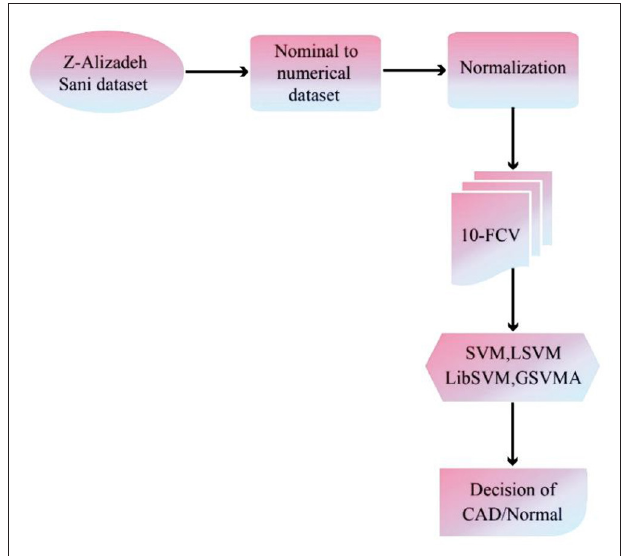
FIGURE 1 | The proposed methodology